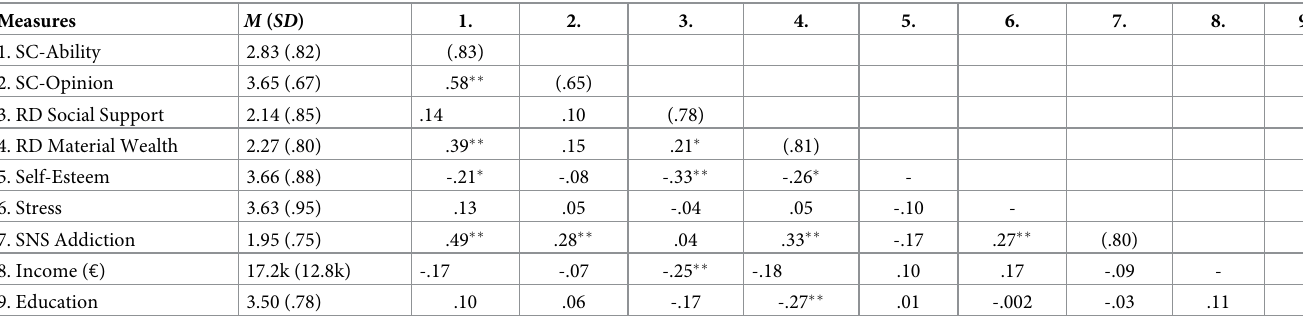
Table 1. Descriptive statistics and intercorrelations for measures in Study 1.